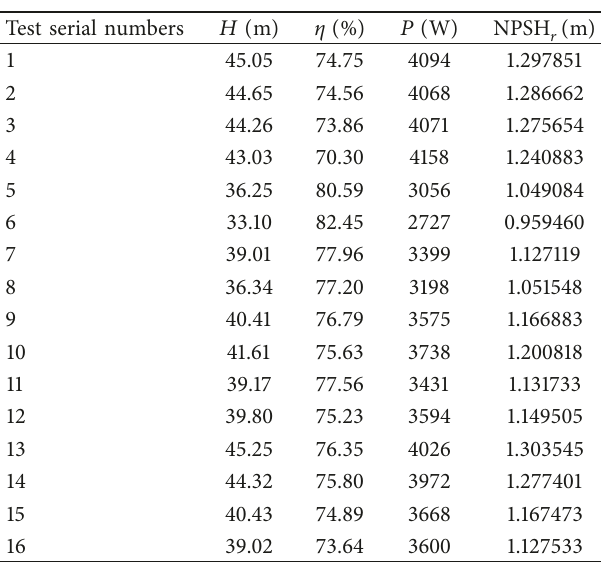
Table 5: Orthogonal test results.